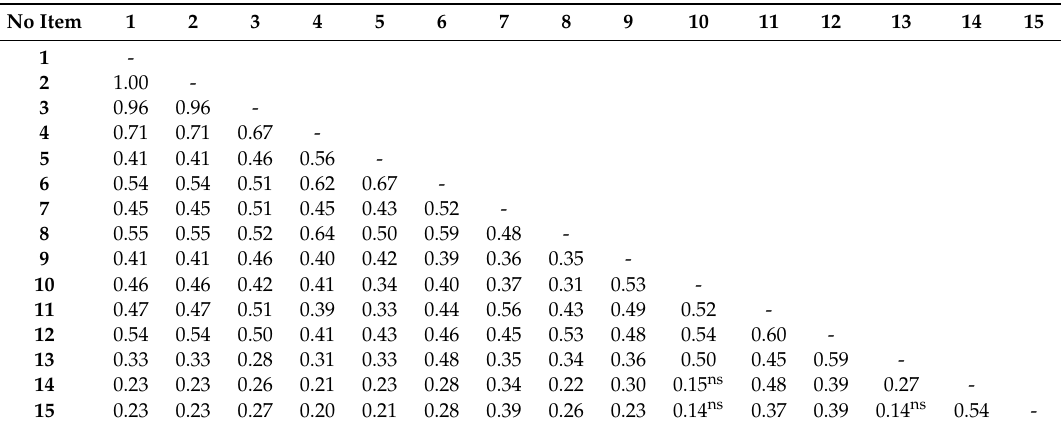
Table 1. Bivariate correlations between the items of the